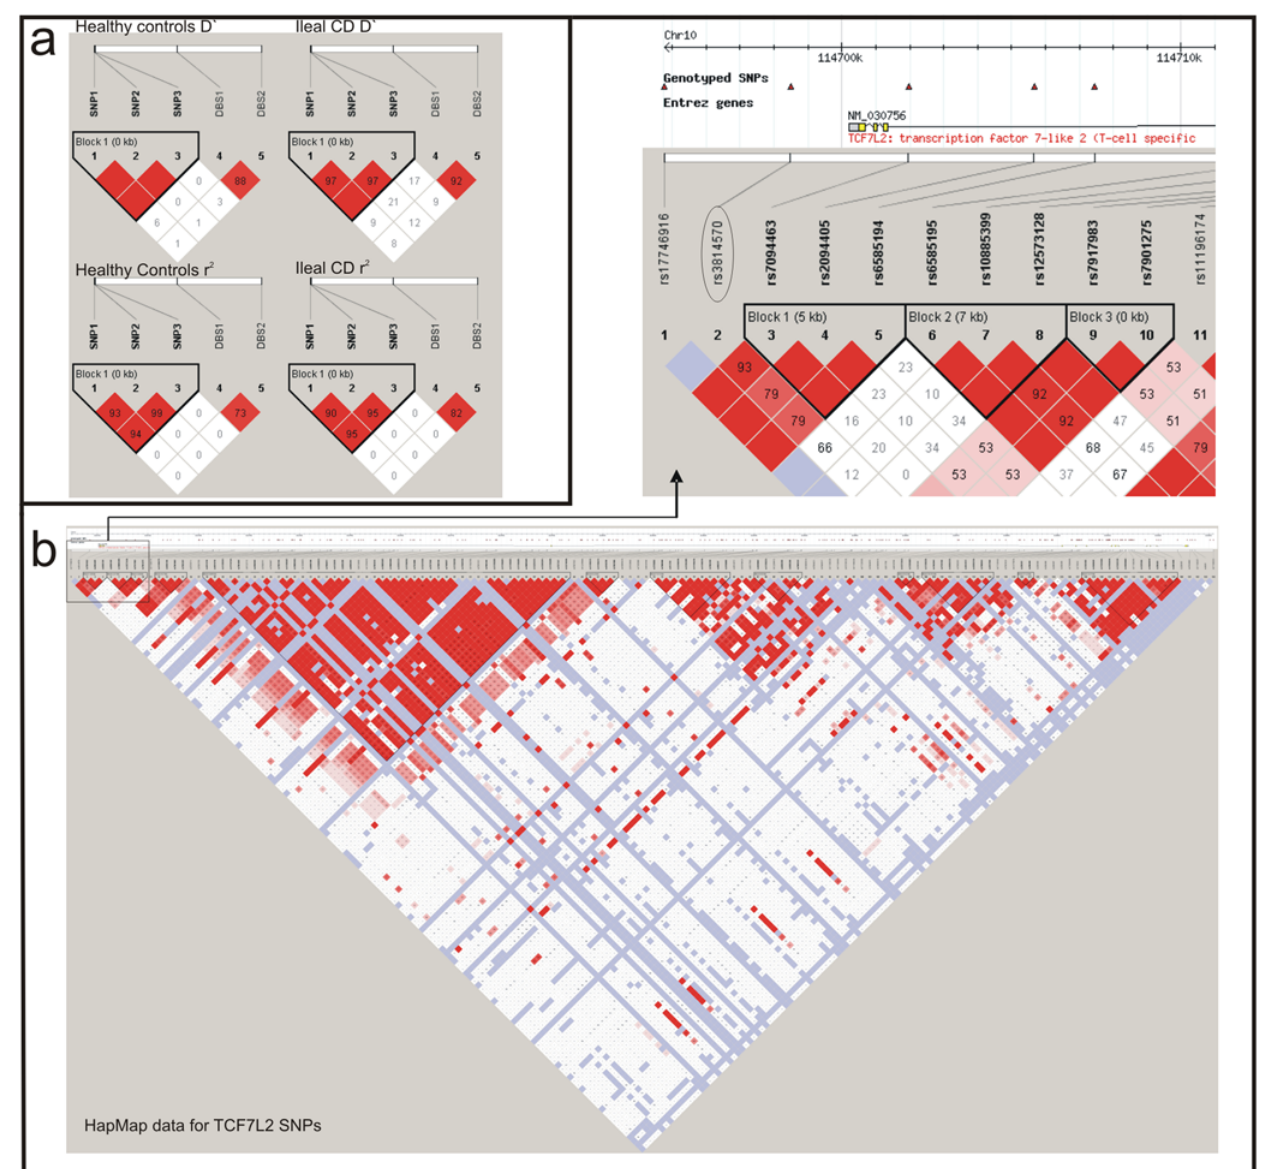
Figure 2. Distribution of haploblocks of TCF-4 ( TCF7L2 ). Both colour schemes (a and b) illustrate the linkage disequilibria. The variants are listed in the upper part of a and b, respectively. Haplotypes for TCF-4 ( TCF7L2 ) rs3814570 (SNP1), rs10885394 (SNP2), rs10885395 (SNP3) and SNPs associated with diabetes in the Vienna cohort are shown in a. A missing number for D 9 or r 2 equals 1. Figure 2b: HapMap data based haplotype blocks and linkage disequilibria (LD) for TCF-4 ( TCF7L2 ) polymorphisms. The intensity of red colouring in b is proportional to the extent of D 9 or r 2 respectively and a missing number for each of them equals. The observed SNP in the putative promoter region is not part of any significant haplotype